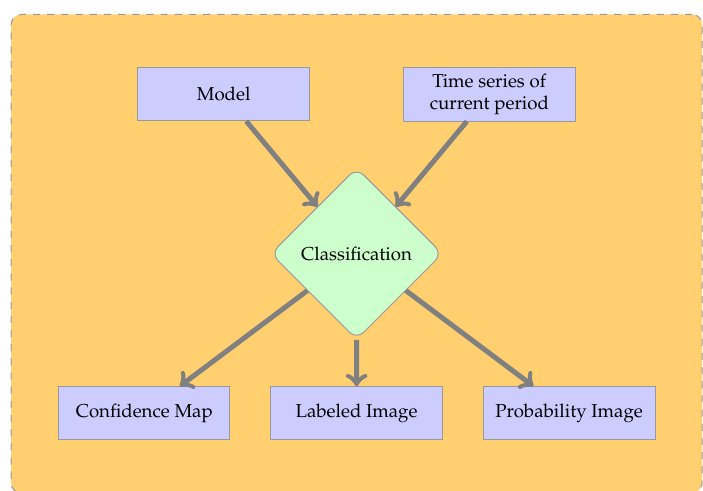
Figure 3. Workflow of classification application. In the standard supervised case, the model is obtained by training the classifier with labeled samples of the current period image time series. In the other cases, the model is trained with labeled samples from previous period image time